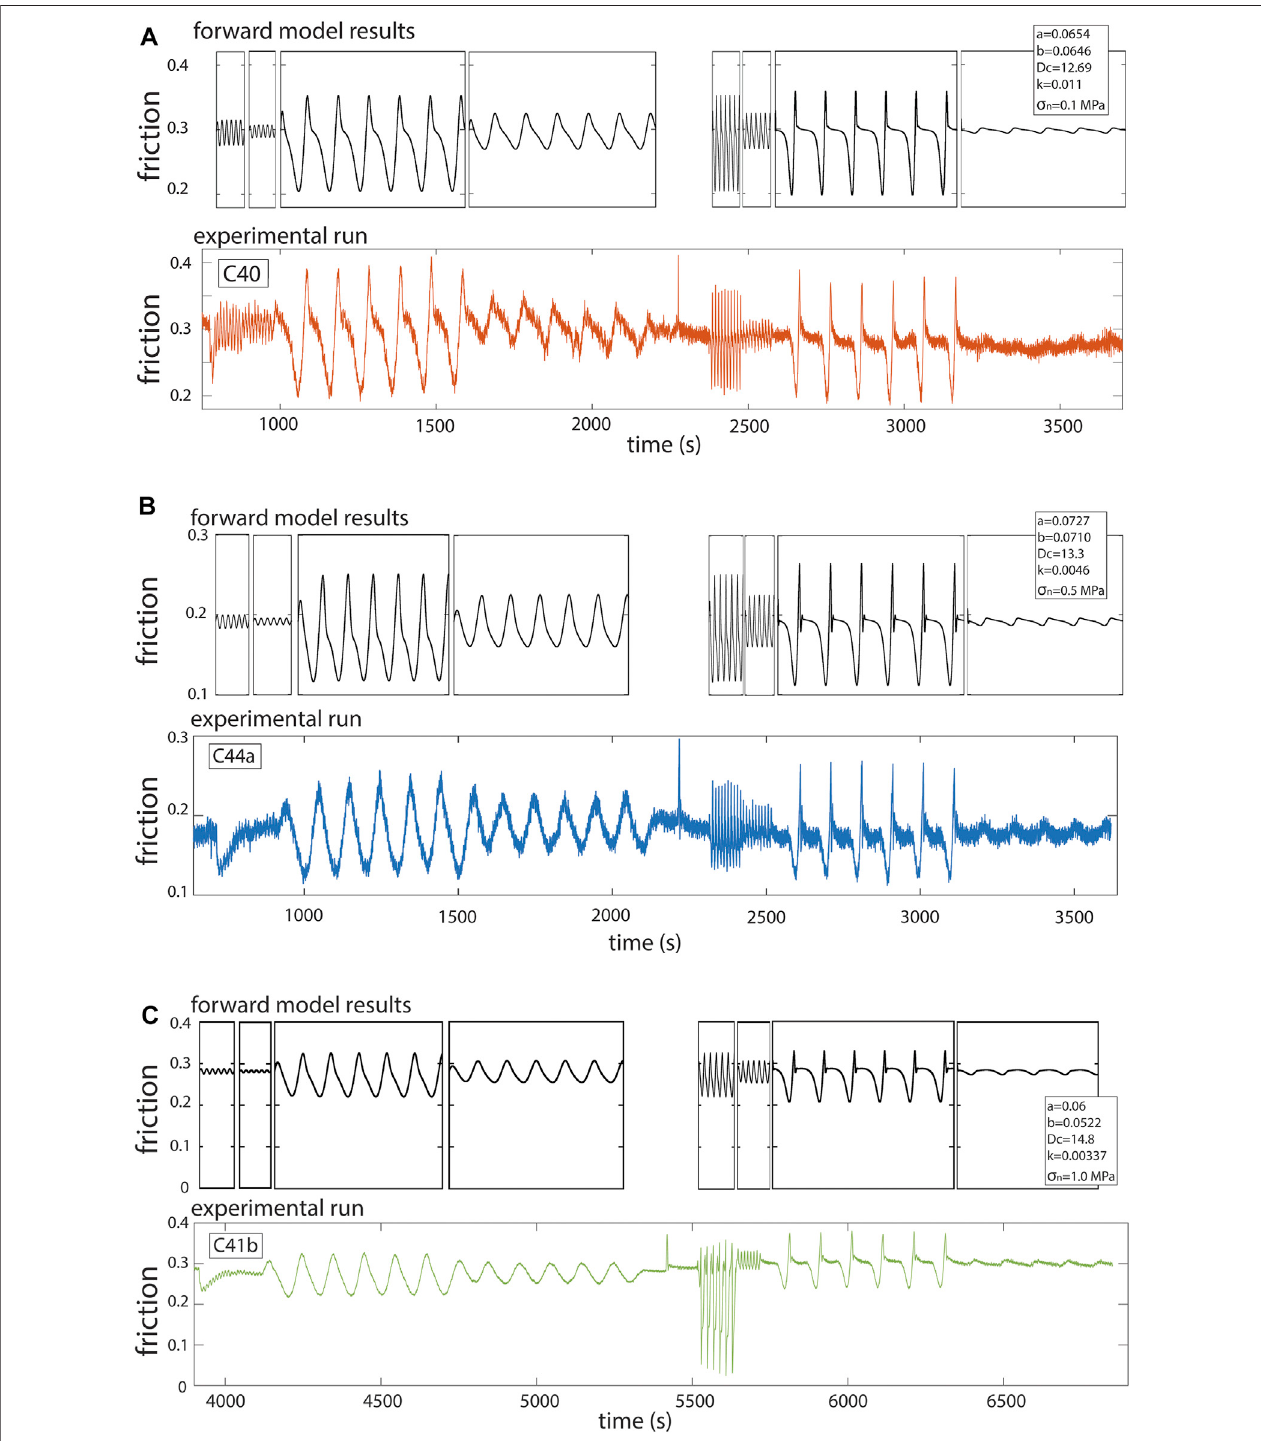
FIGURE 9 | Forward model results compared to three selected experimental runs. Values for models are those listed, which are determined from the velocity step analysis( Table2 )usingtheSlipformofstate (A) atnormalstress=0.1 MPa; (B) atamid-rangeofnormalstress=0.5 MPa;and (C) athighestnormalstress=1.0 MPa.